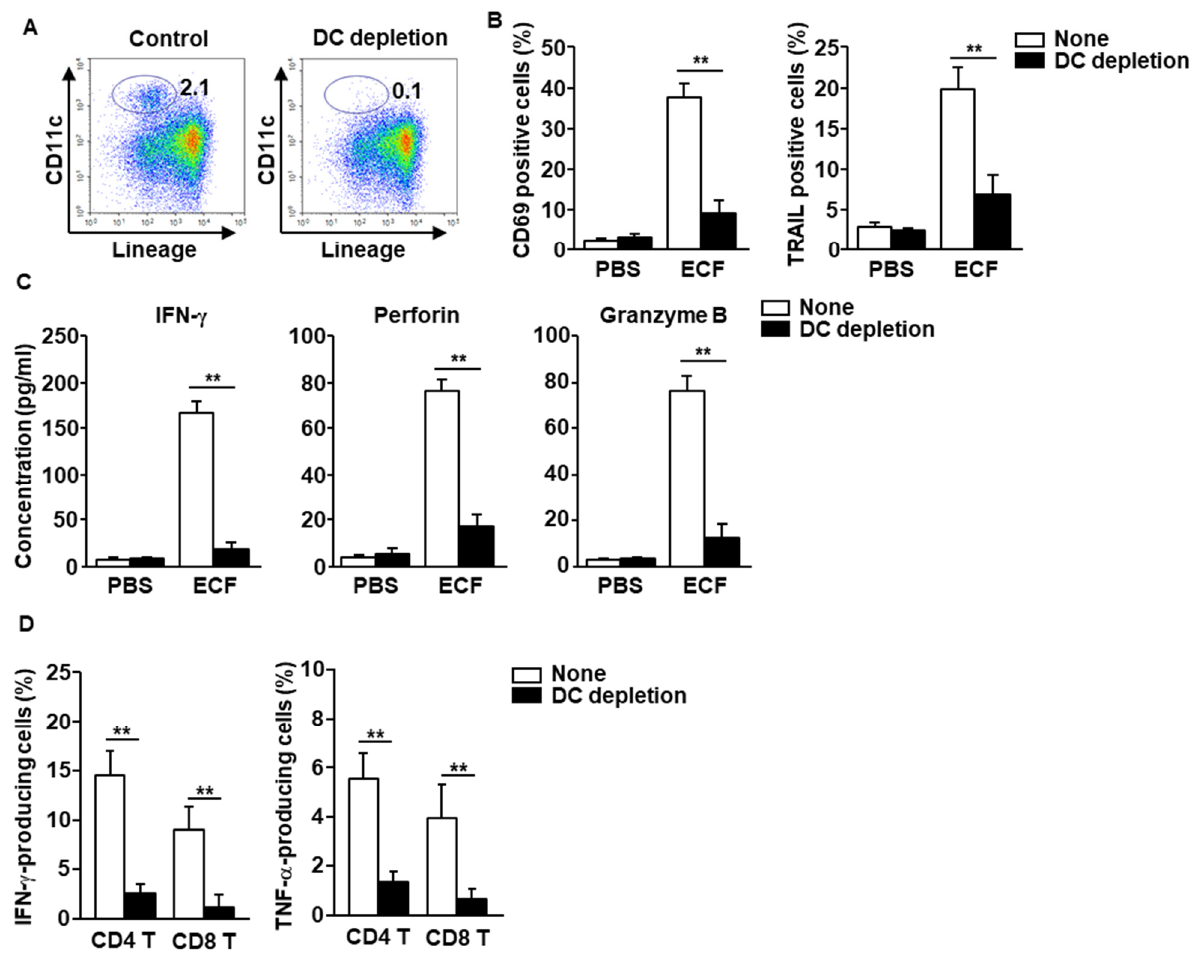
Figure 4. DCs are required for stimulation of NK and T cells in the mLN. ( A ) DCs in mLN cells were depleted, as described in the Methods. ( B ) CD69 and tumor necrosis factor-related apoptosis-inducing ligand (TRAIL) expression levels, as measured 24 h after treatment with 100 μ g/mL of ECF. PBS, phosphate-buffered saline ( n = 6, two-way analysis of variance, ** p < 0.01). ( C ) The concentration of IFN- γ , perforin, and granzyme B in the cultured medium was shown. ( D ) Percentage of intracellular IFN- γ - and TNF- α -producing T cells in mLN cells after culture with or without 100 μ g/mL ECF for 3 days, as analyzed by flow cytometry ( n = 6, two-way analysis of variance).